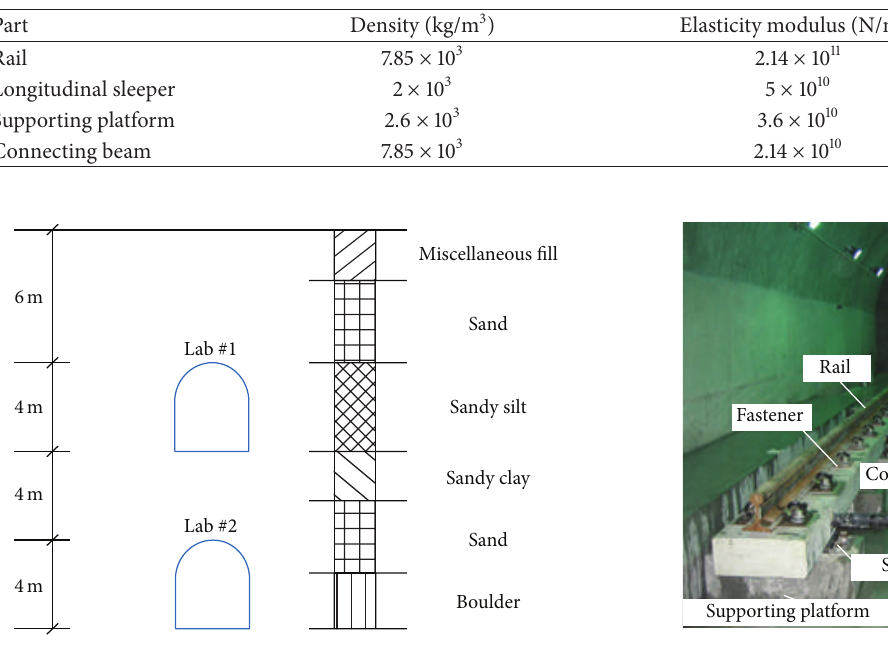
Table 1: Properties of the ladder track.